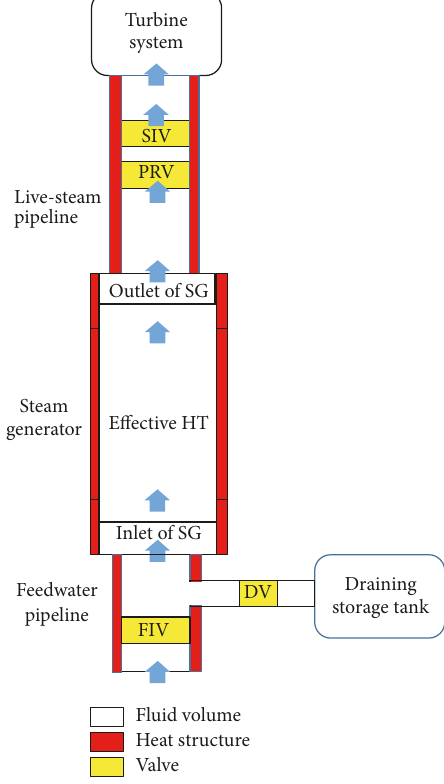
Figure 3: Secondary loop model of the